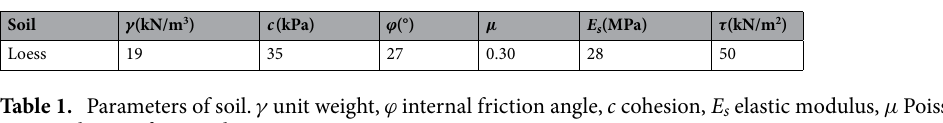
Table 1. Parameters of soil. γ unit weight, ϕ internal friction angle, c cohesion, E s elastic modulus, µ Poisson’s ratio, τ ultimate